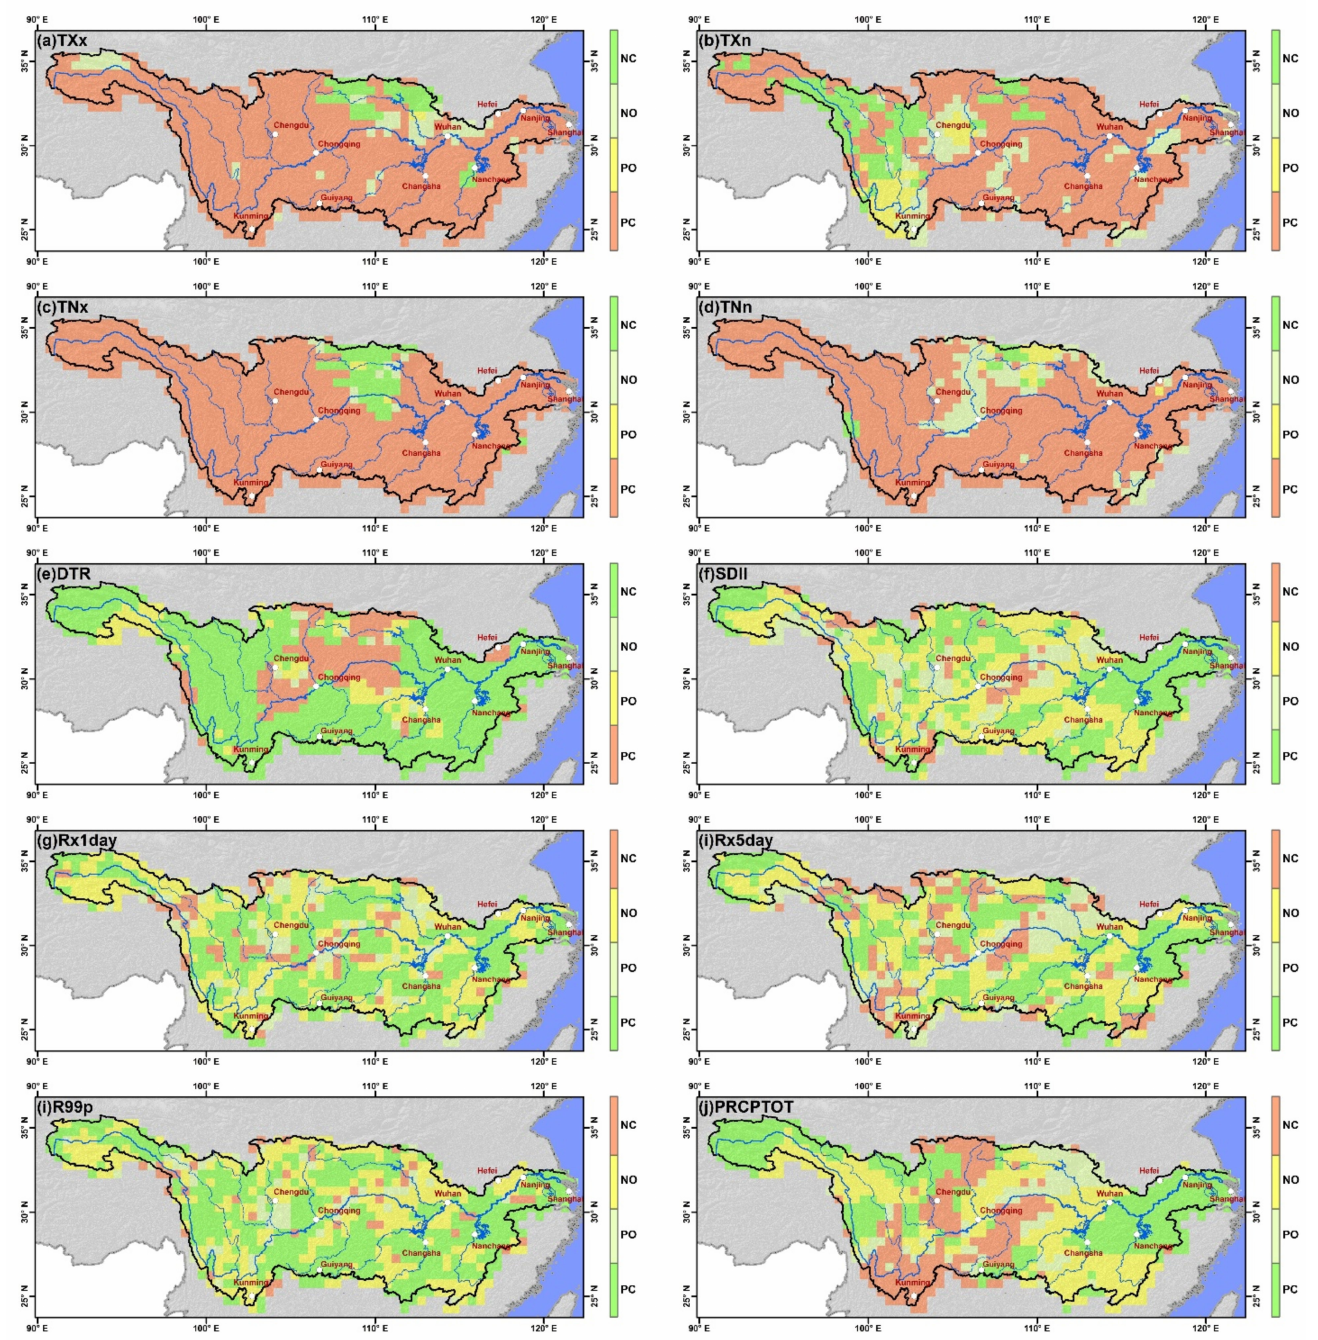
Figure 5. Spatial distribution of the extreme precipitation and temperature indices future trend: ( a ) TXx; ( b ) TXn; ( c ) TNx; ( d ) TNn; ( e ) DTR; ( f ) SDII; ( g ) Rx1day; ( h ) Rx5day; ( i ) R99p; ( j ) PRCPTOT. NC, NO, PO, PC are abbreviations for “Negative– Consistent“, “Negative–Opposite”, “Positive–Opposite”, “Positive–Consistent”, respectively. In most areas of the lower reaches of the Yangtze River, annual SDII, Rx1day, Rx5day, R99p, and PRCPTOT increased by more than 0.2 mm/10a, 3.0 mm/10a, 5.0 mm/10a, 10 mm/10a, and 20 mm/10a, accounting for 17.1%, 11.6%, 12.6 percent, 21.4%, and 22.7% of the area of the YRB, respectively. In some scattered areas in the middle reaches of the Yangtze, annual SDII, Rx1day, Rx5day, R99p, and PRCPTOT had decreased by more